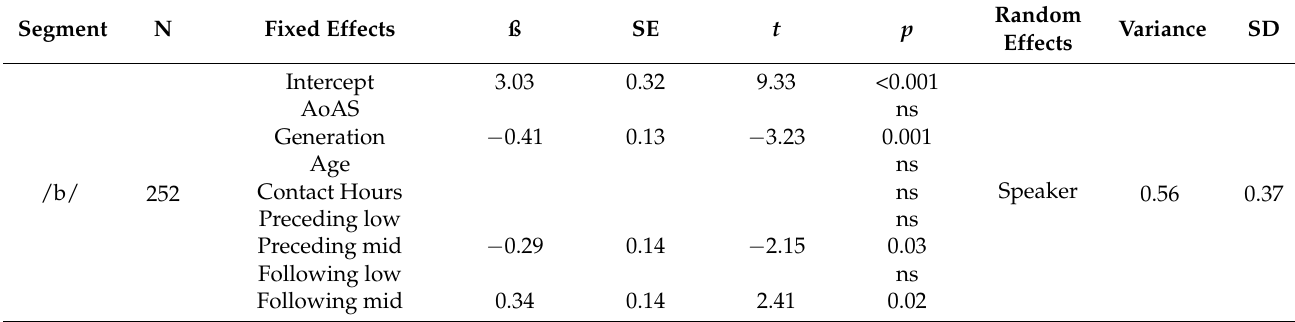
Table A1. Statistical results from Linear Mixed-Effects Models; the dependent variable is continuous from 1 (occlusive) to 3 (full